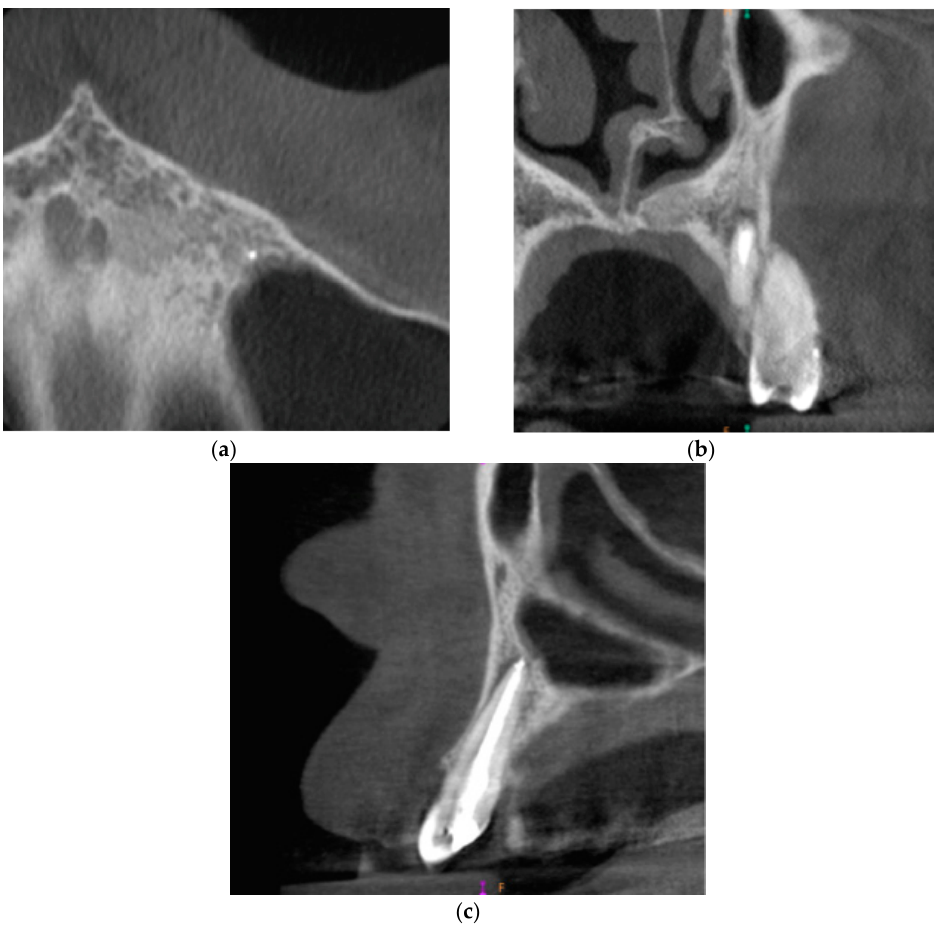
Figure 4. CBCT images presenting the healing process of the periapical lesion around the root of tooth no. 23 (date of CBCT examination: 8 December 2020): ( a ) axial view; ( b ) coronal view; and ( c ) sagittal view.